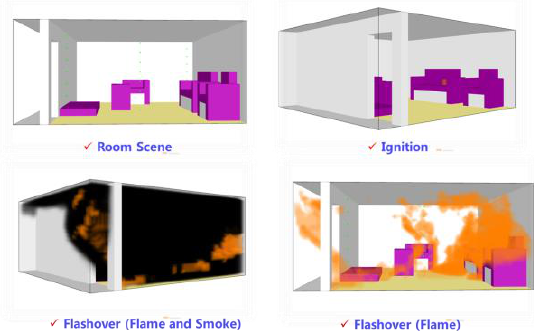
Figure 5. The simulation results from FDS for validation of ignition and flashover events